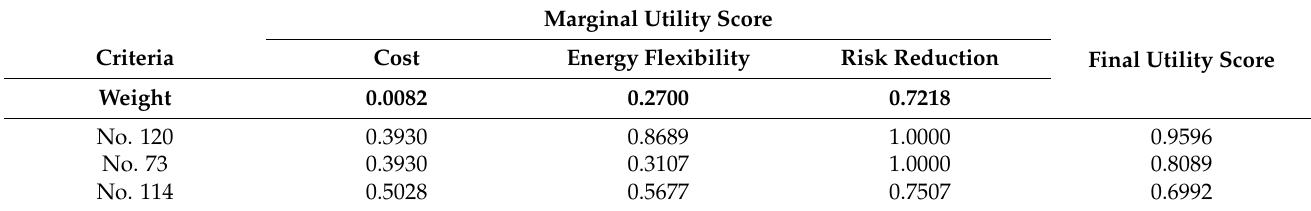
Table 5. Marginal and final utility scores of the three best performing paths.